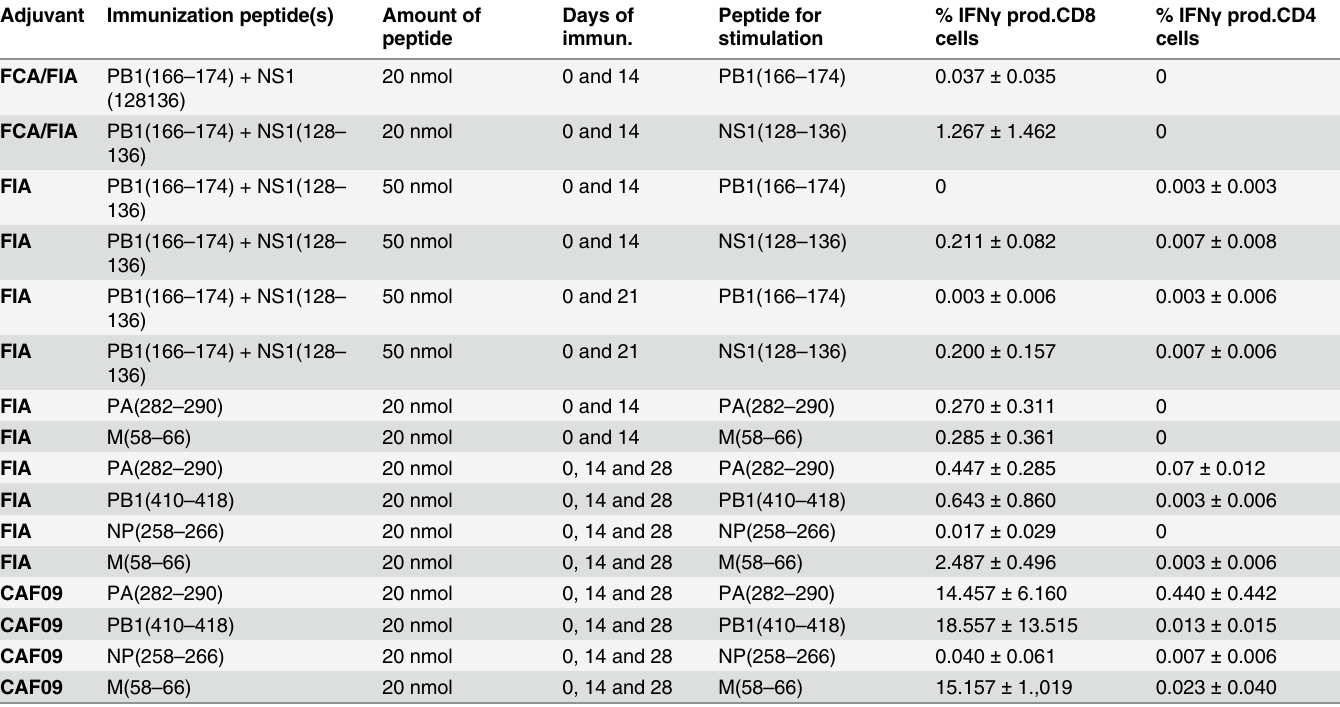
Table 2. FACS analysis of splenic T cells *